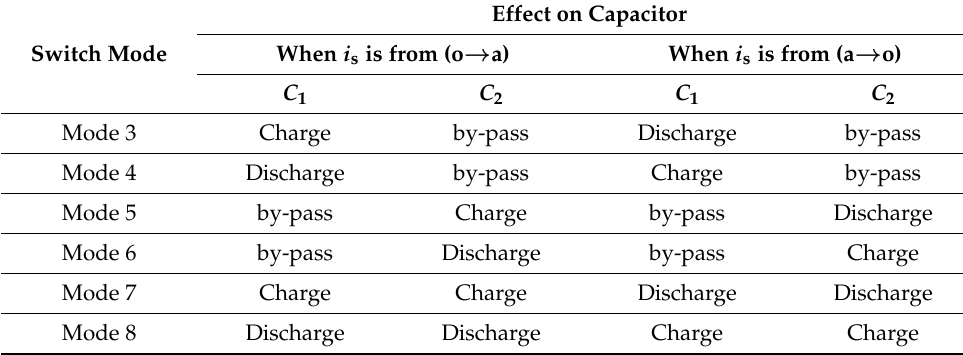
Table 2. Effect on DC-Link